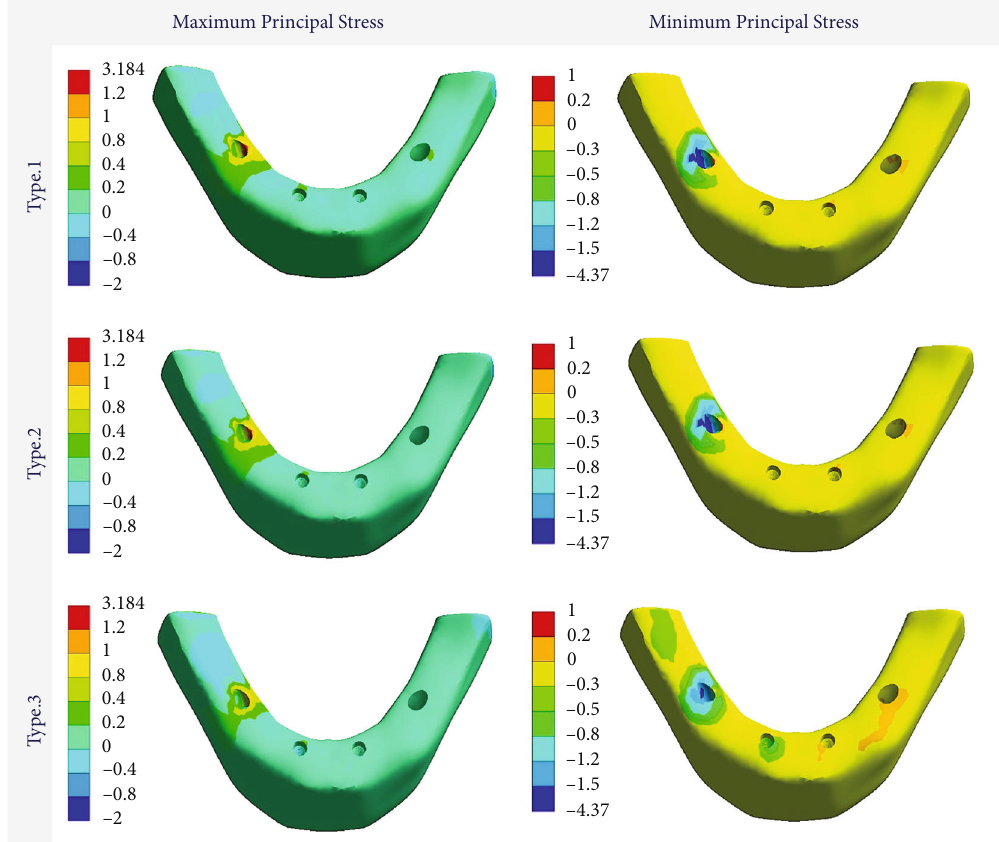
Figure 10: Maximum and minimum principal strains ( με ) on cancellous